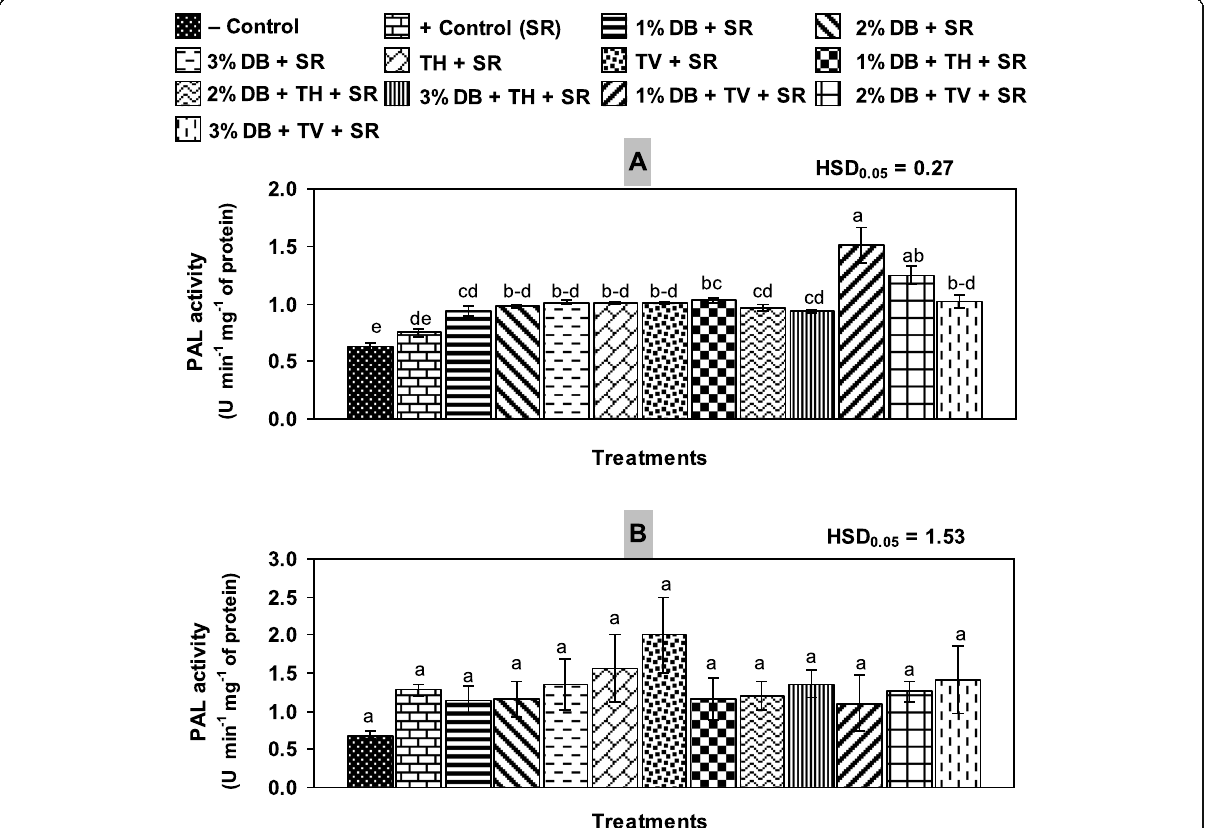
Fig. 3 Effect of Sclerotium rolfsii (SR), Trichoderma harzianum (TH), T. viride (TV), and dry biomass (DB) of Chenopodium album on leaf and root polyphenol ammonia lyase (PAL) activity of chickpea var. Noor 2009. Vertical bars show standard errors of means of five replicates. Values with different letters at their top show significant difference ( p ≤ 0.05) as determined by Tukey ’ s HSD